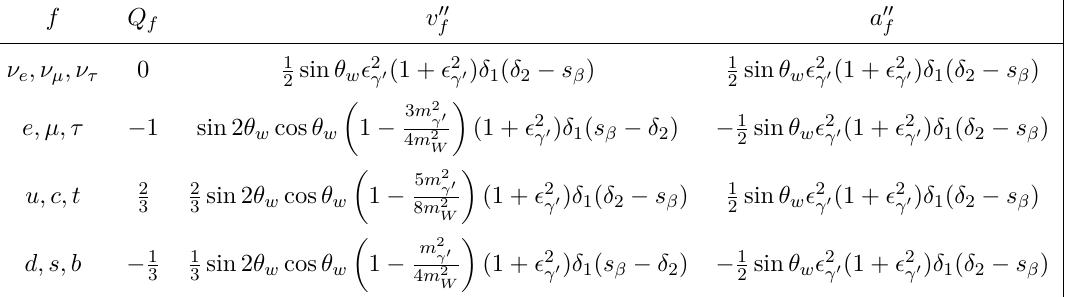
Table 2 . The Z → f ¯ f and Z 0 → f ¯ f vertices. In the above, (cid:15) z = m Z 0 /m Z and m W is the W boson mass.